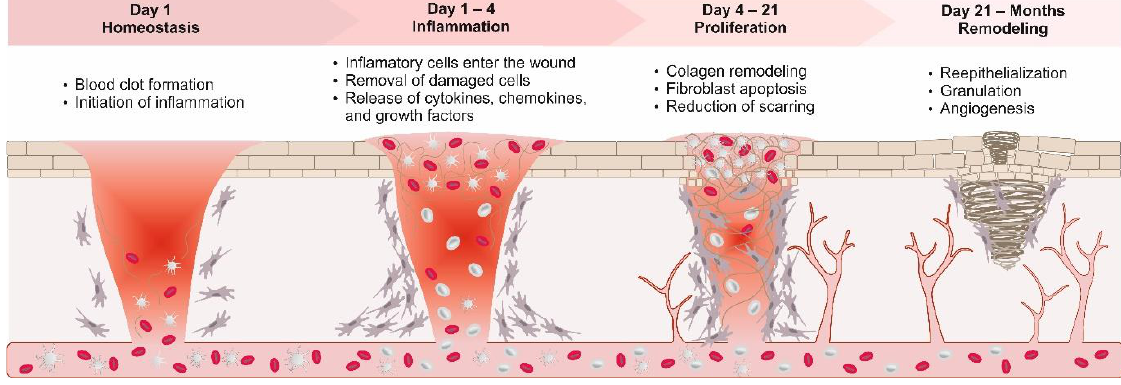
Figure 2. Visualization of the wound healing process and its outcomes.